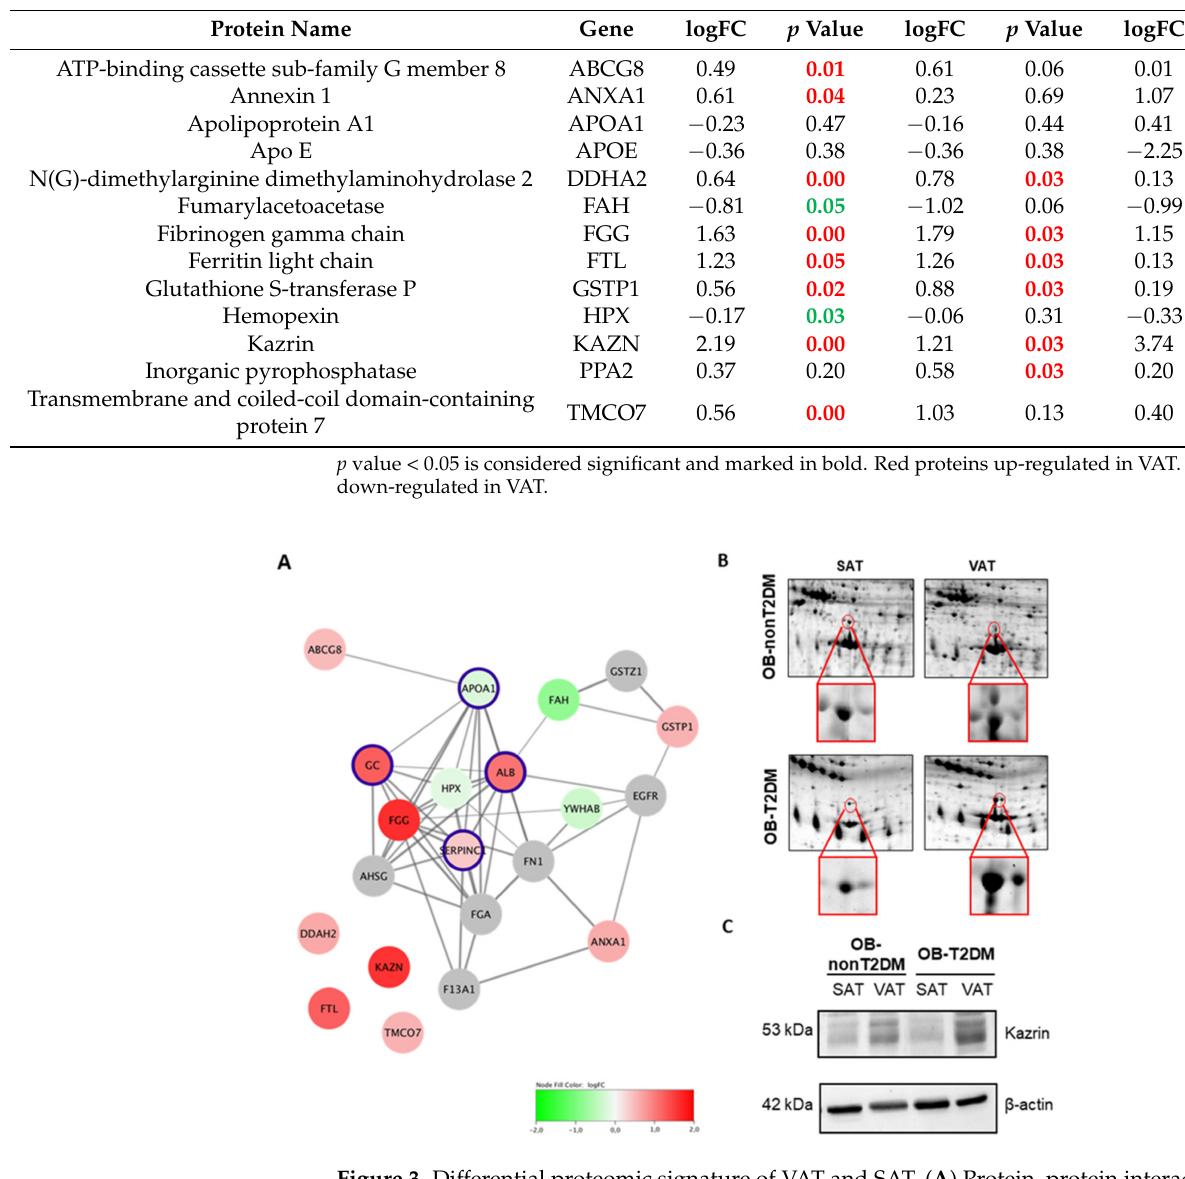
Figure 3. Differential proteomic signature of VAT and SAT. ( A ) Protein–protein interaction network analysis of visceral versus subcutaneous adipose tissue differentially expressed proteins. Nodes coloring represents log fold-change between VAT and SAT; gray nodes represent predicted protein interactions; nodes highlighted in purple represent predicted proteins that were detected within the proteomic analysis but did not reach significance. Red up regulated and green down regu- lated. ( B ) Representative two-dimensional electrophoresis image of adipose tissue with kazrin spot (MW: 86 kDa, pI: 6.6) highlighted in a circle. ( C ) Kazrin protein expression in SAT and VAT from class III obese (OB) individuals with and without type 2 diabetes (T2DM or nonT2DM). Blots are representative of 6 independent